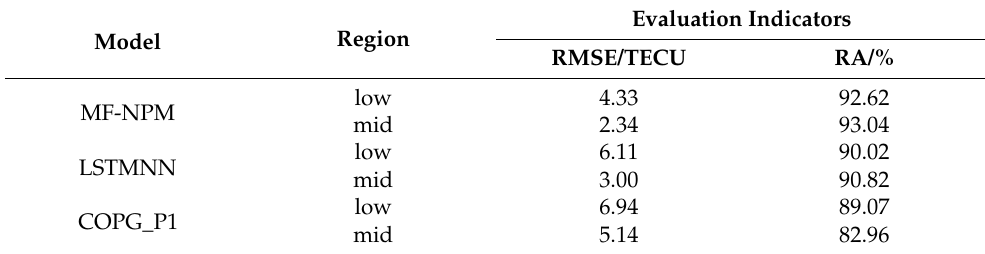
Table 6. RMSE and relative accuracy of the model outcomes (MF-NPM, LSTMNN, and COPG_P1) from IGS GIMs in different latitudes during geomagnetic storms. Model Region